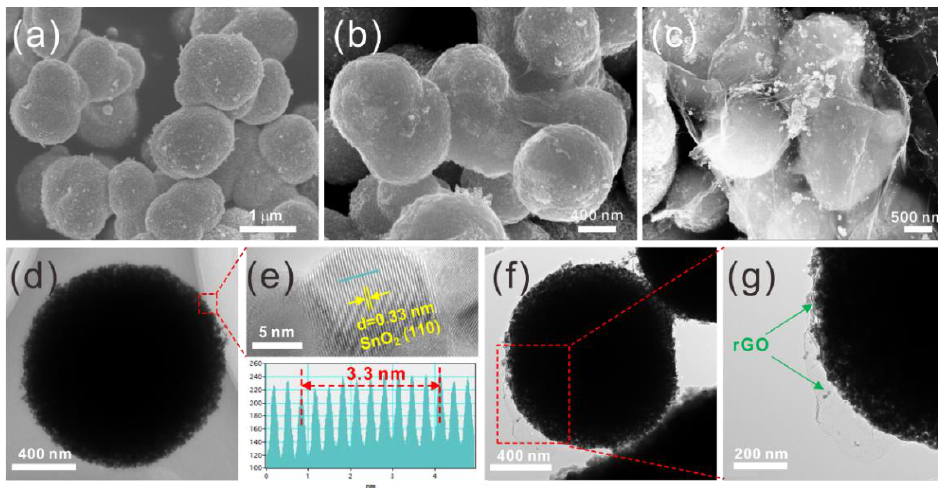
Figure 4. SEM images of S1 ( a ), S2 ( b ), and S3 ( c ); TEM images of S1 ( d , e ) and S2 ( f , g ).